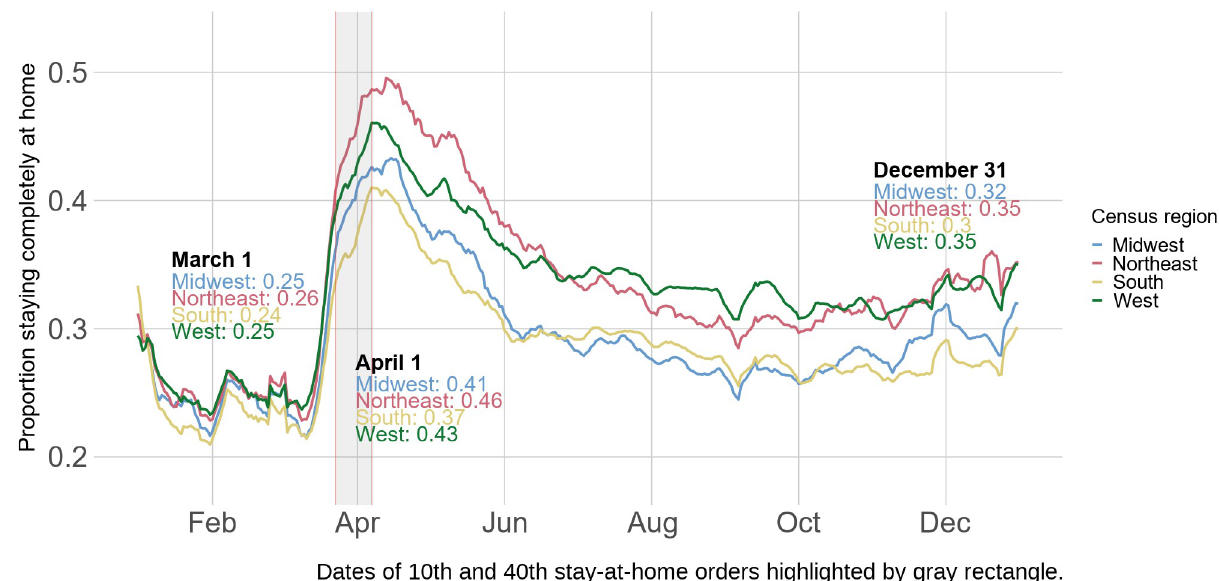
Fig 1. Stay-at-home patterns by Census